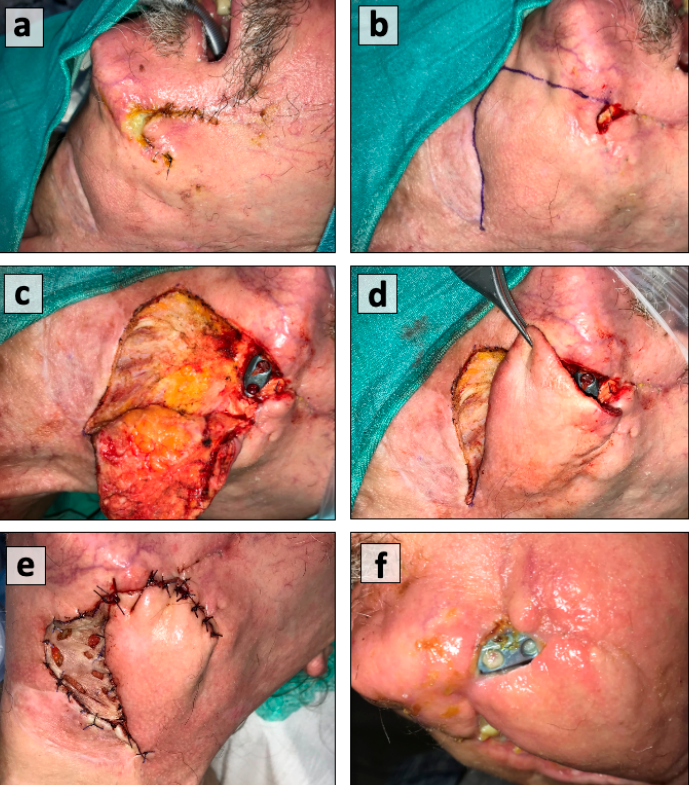
Figure 4. ( a ) Exposure of reconstruction plate post irradiation, ( b ) wound debridement and marking of advancement rotation flap, and ( c ) raising the flap; ( d ) adequacy of flap for plate coverage, ( e ) local infection resulting in flap dehiscence and plate exposure again, and ( f ) no wound coverage despite using NPWT.